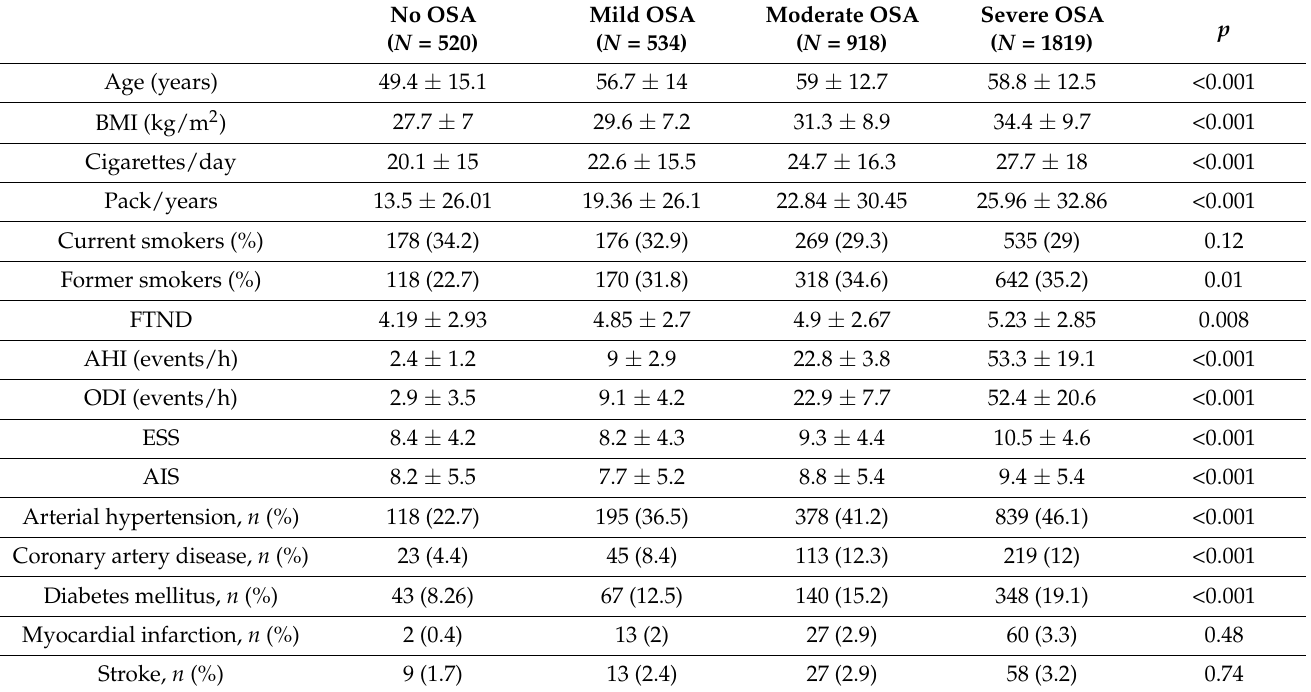
Table 2. Characteristics of the participants according to the severity of